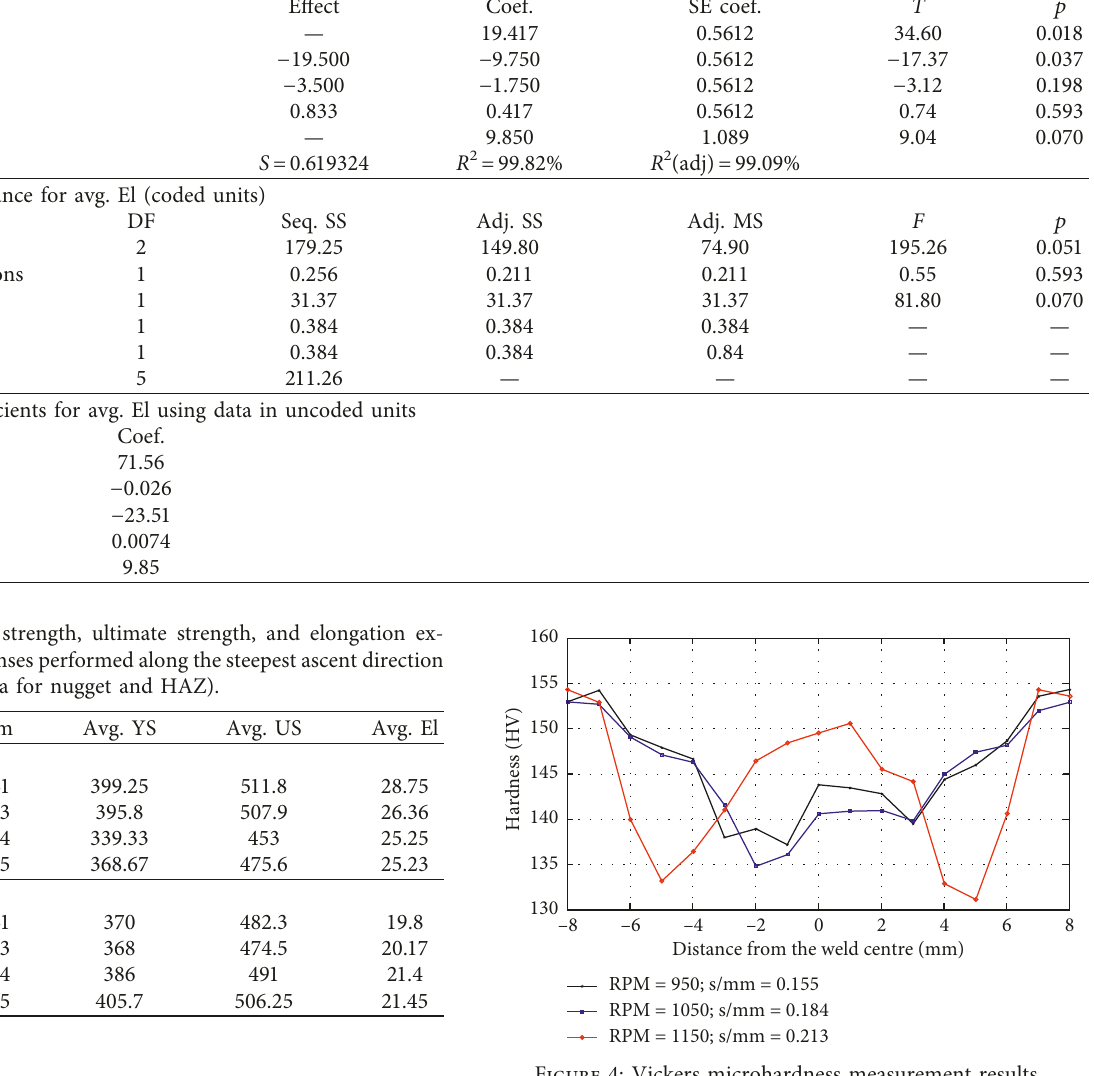
Table 9: Results of elongation analysis of variance (nugget zone).